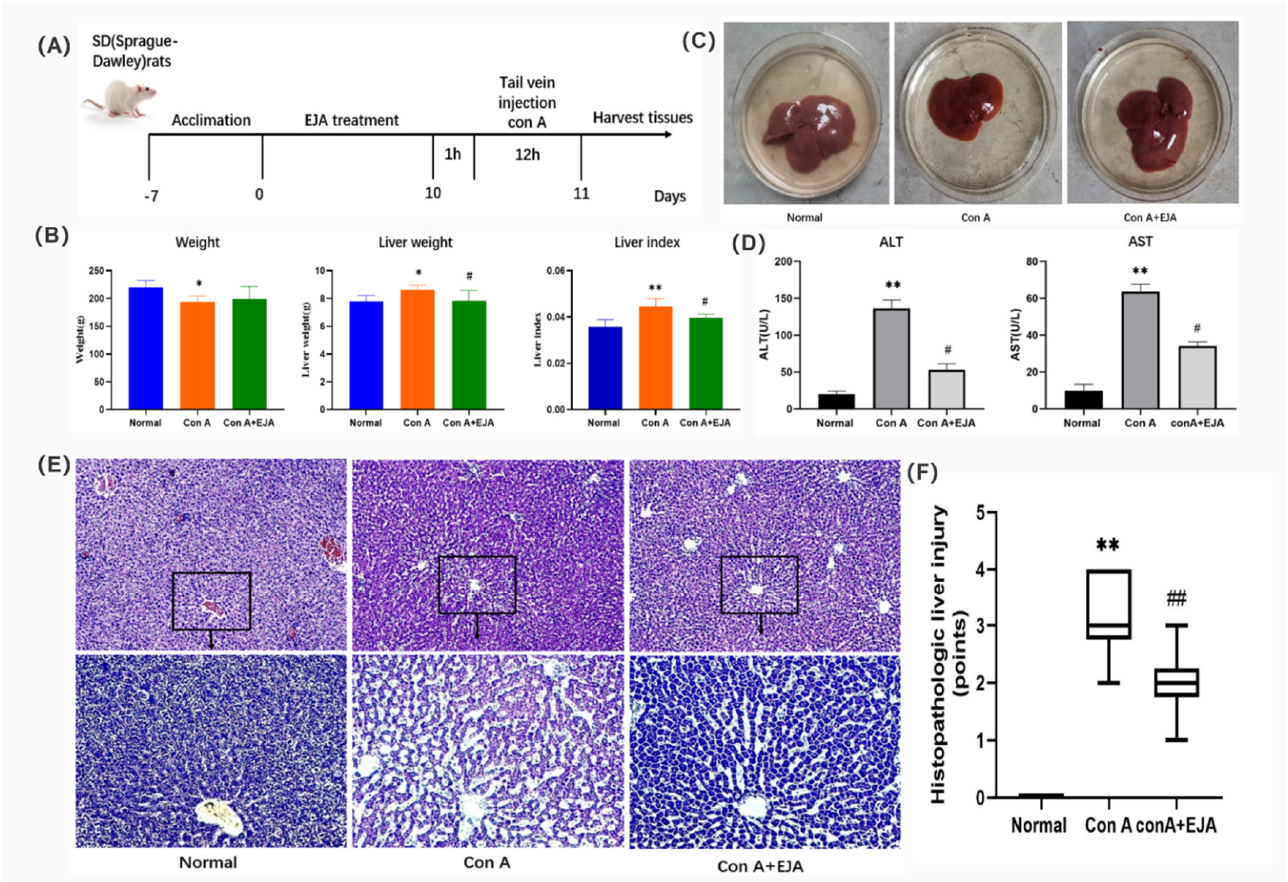
Figure 8. ( A ) Description of the rat model of acute immune liver injury used in this study. ( B ) Body weight, liver weight, and liver coefficient changes in rats 10 days after EJA treatment. Compared with normal group, ** p < 0.01, * p < 0.05; Compared with model group, # p < 0.05. Note: EJA is an extract of Japanese Ardisia. Data were shown as mean ± SEM ( n = 6 per group). ( C ) Rat liver treated with EJA. ( D ) Effect of EJA on serum ALT and AST levels. Compared with normal group, ** p < 0.01; Compared with model group, # p < 0.05. Note: EJA: an extract of Japanese Ardisia. Data were shown as mean ± SEM ( n = 3 per group). ( E ) Histopathological sections of rat liver (HE staining, 200× 400×). ( F ) Effect of Japanese Ardisia pretreatment on the scoring of liver pathological sections of rats with con A-induced liver injury. Compared with normal group, ** p < 0.01; compared with model group, ## p < 0.01. Note: EJA is an extract of Japanese Ardisia. Data were shown as mean ± SEM ( n = 6 per group). Scoring criteria: 0—no necrosis; 1—individual cell necrosis; 2—less than 30% necrosis; 3— 30-60% necrosis; 4—greater than 60% necrosis [22].